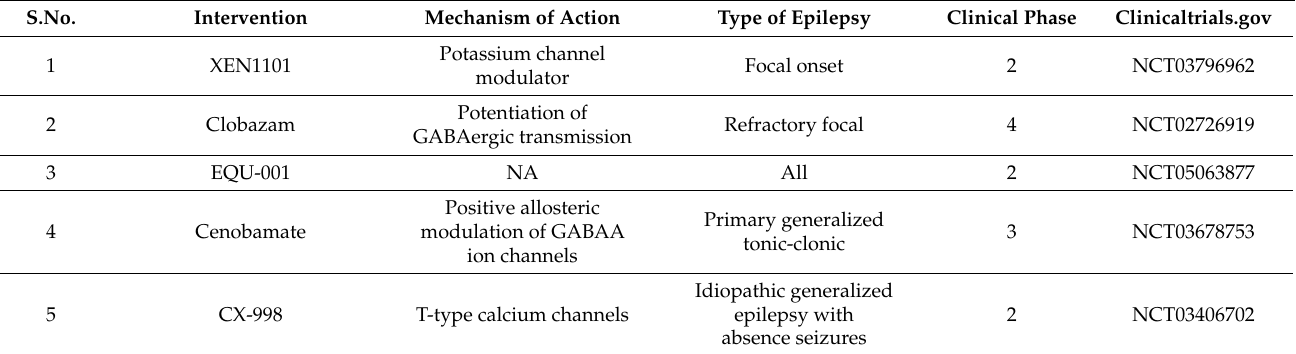
Table 2. Pharmacological treatments undergoing clinical trials. This table lists the relevant clinical details of the pharmacological treatments inclusive of monotherapy and polytherapy along with their mechanism of action/actions, type of epilepsy, current clinical phase, and identifiers available on the website https://clinicaltrials.gov (accessed on: 15 July